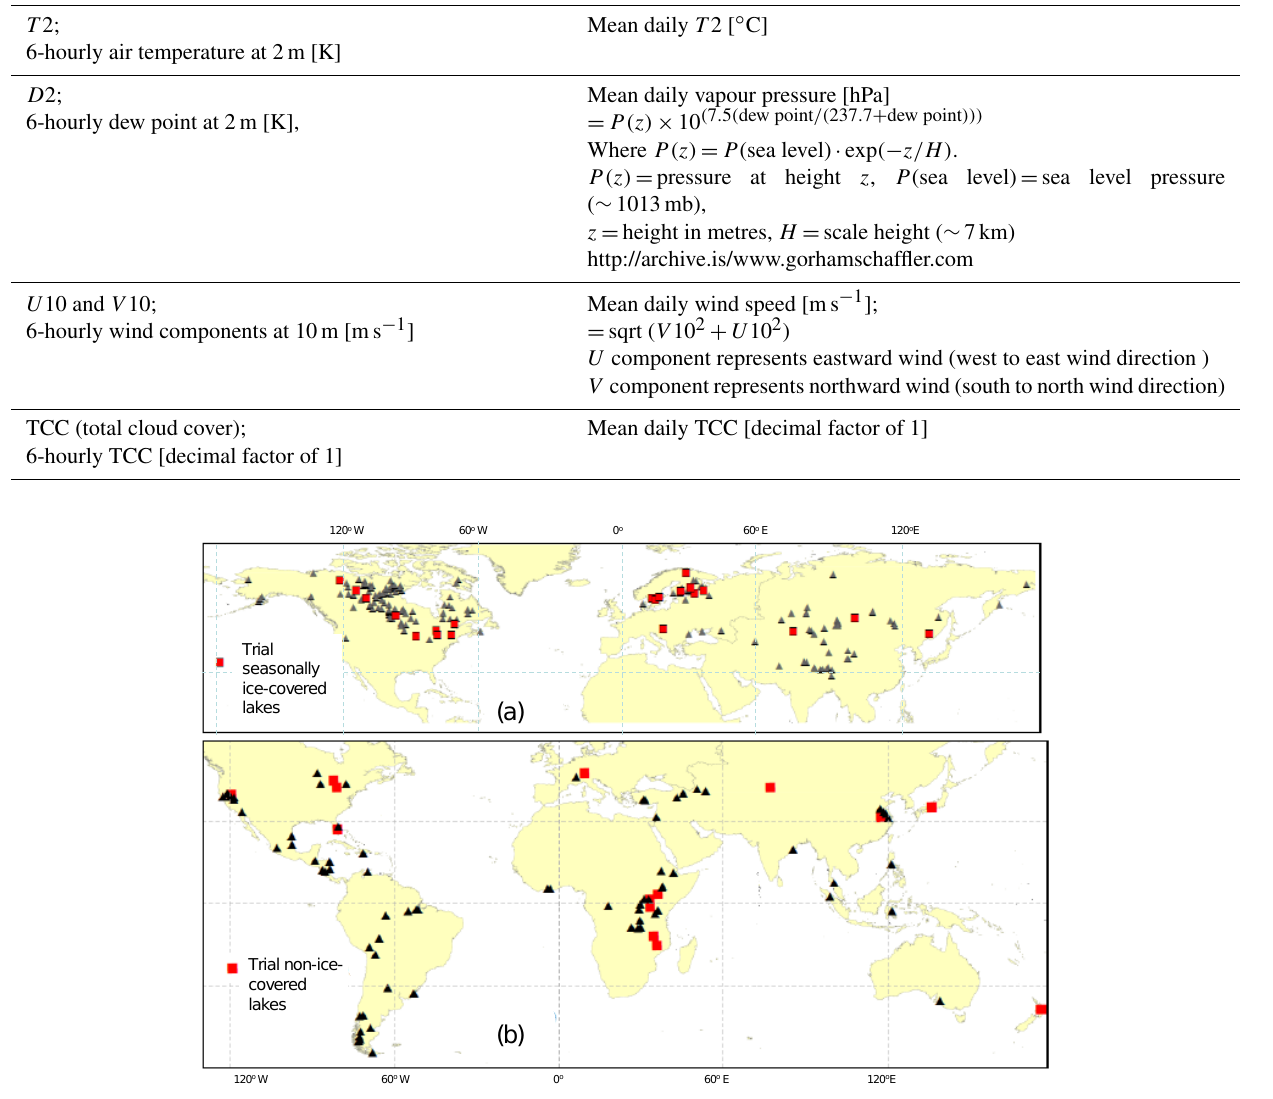
Figure 6. Location of lakes, with red square showing the trial lakes (a) 160 seasonally ice-covered lakes, including 21 trial lakes and (b) 86 non-ice-covered lakes including 14 trial